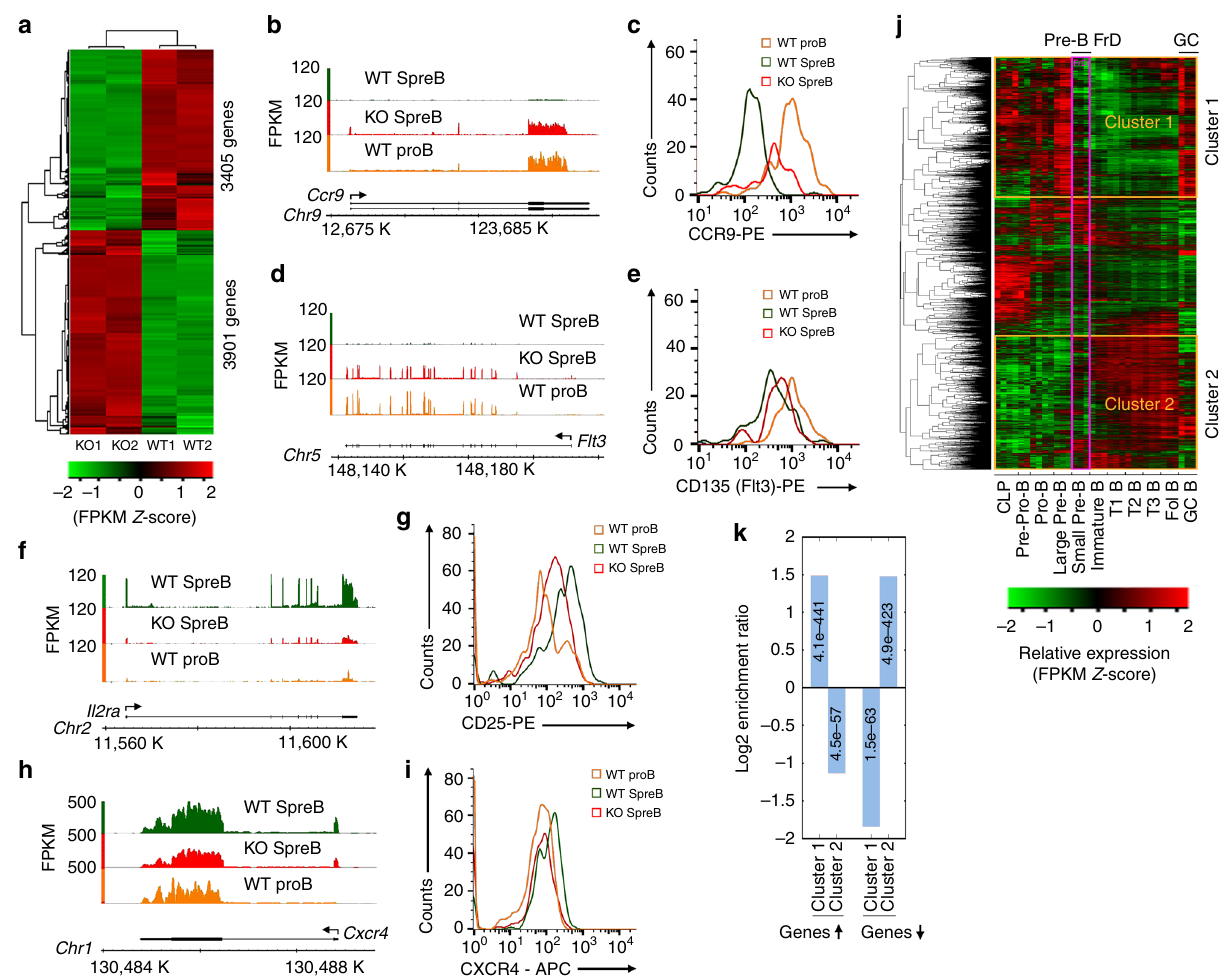
Fig. 1 BRWD1 orchestrates transcriptional programs of late B-cell development. a Heatmap of RNA-Seq results with clustering of upregulated and downregulated genes in Brwd1 -/- vs. WT small pre-B cells ( q < 0.05, replicates shown). b , e Representative RNA-Seq alignments for Ccr9 ( b ) and Flt3 ( d ) in WT and Brwd1 -/- small pre-B cells. Corresponding surface expression of CCR9 ( c ) and FLT3 ( e ) on indicated cell populations as assessed by fl ow cytometry. f , i . Representative RNA-Seq alignments for Il2ra ( f ) and Cxcr4 ( h ) in WT and Brwd1 -/- small pre-B cells. Corresponding surface expression of CD25 ( g ) and CXCR4 ( i ) on indicated cell populations as determined by fl ow cytometry. j Gene expression microarray data from ImmGen ( 10 ) covering ten B-cell development and maturation stages including common lymphoid progenitor (CLP), and transitional (T1-3) and germinal center (GC). A total of 13387 differentially expressed genes (one-way ANOVA, q < 0.05) were hierarchically clustered. k Log 2 enrichment of Cluster 1 and Cluster 2 genes with lower and higher transcript abundance in Brwd1 -/- small pre-B cells than in WT small pre-B cells. Corresponding P -values (unpaired t test)